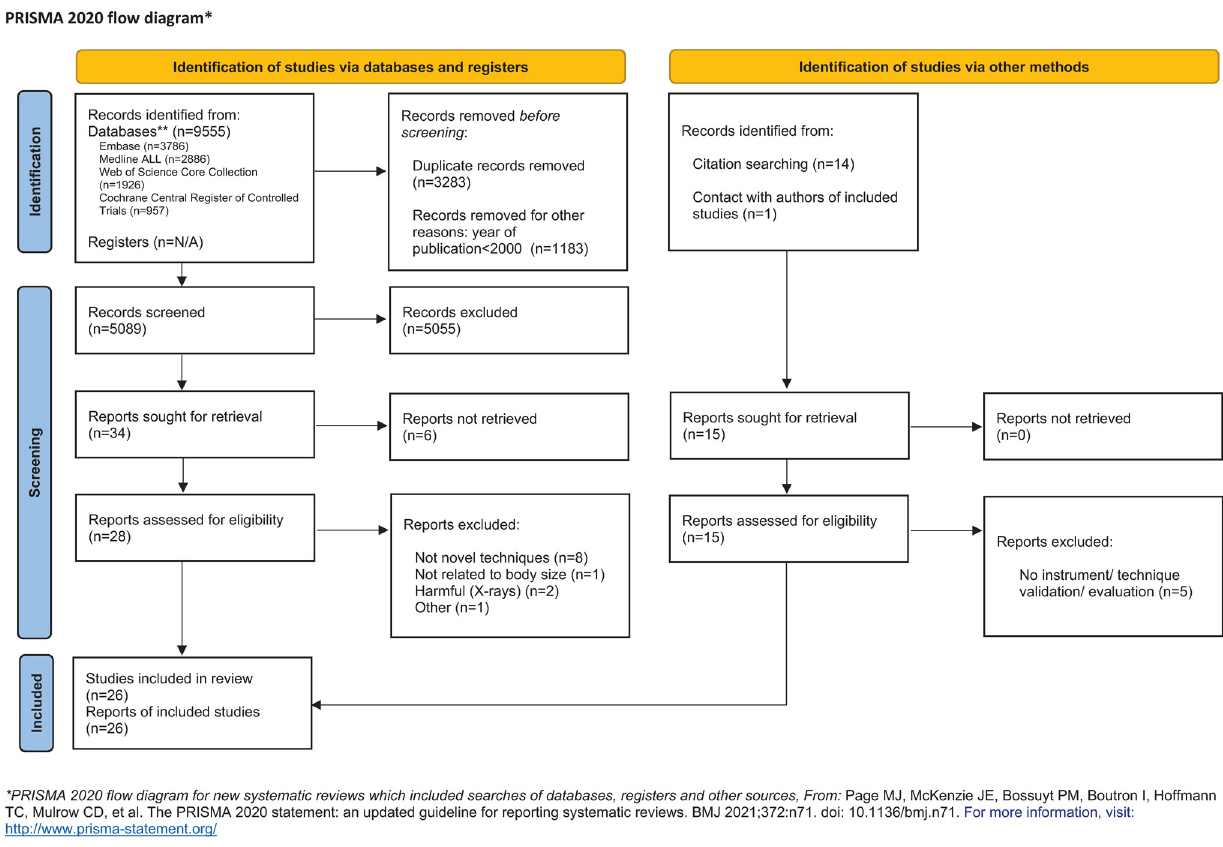
Fig 5. PRISMA 2020 flow diagram for systematic